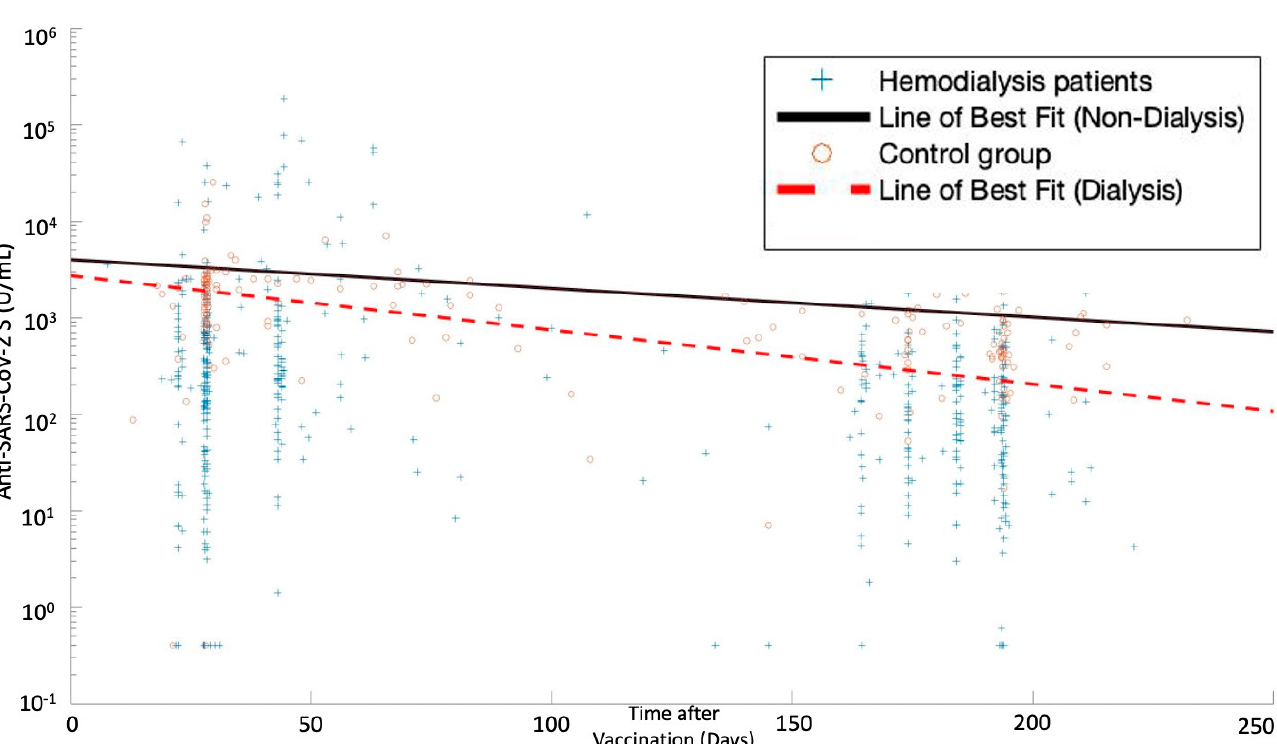
Figure 2. Anti-SARS-CoV-2 S antibody titers versus time after completion of vaccination in hemodialysis patients and controls. The symbols represent individual anti-SARS-CoV-2 S antibody measurements of hemodialysis patients (o) or controls (+). Dynamic profiling utilizing a scatter plot of data points with linear regression analysis of Anti-SARS-CoV-2 S antibody titers in patients undergoing hemodialysis and those not undergoing hemodialysis overtime was performed. We observed that the line of best fit for patients not undergoing hemodialysis and those undergoing hemodialysis is represented by the equation y = − 10.38x + 3965 and y = − 13.01x + 2702. Drawing from the abovementioned equations, we observe that (1) the titers generally decrease over the given period of time and (2) the titers in patients undergoing hemodialysis decrease more rapidly in comparison to those not undergoing hemodialysis (mHemodialysis = − 13.01 vs. mControl = −